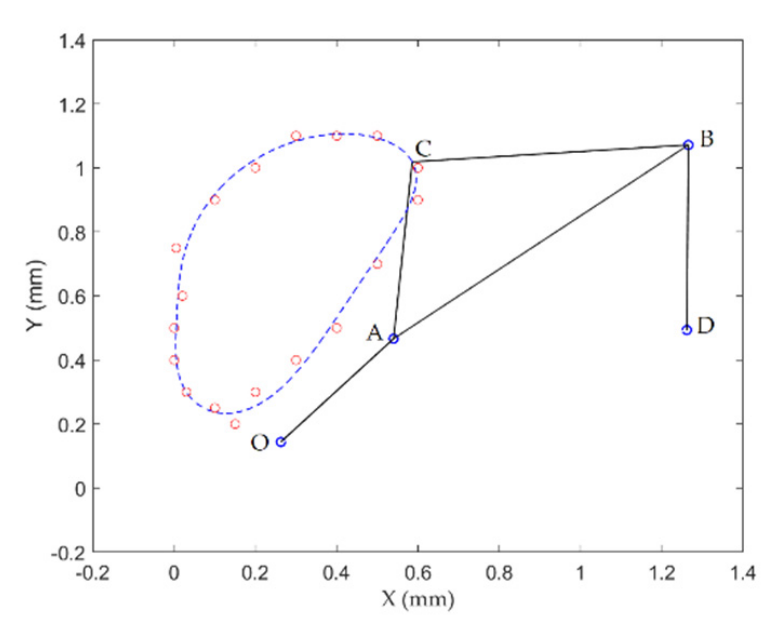
Figure 12. Trajectory of the coupler point of Case 2.